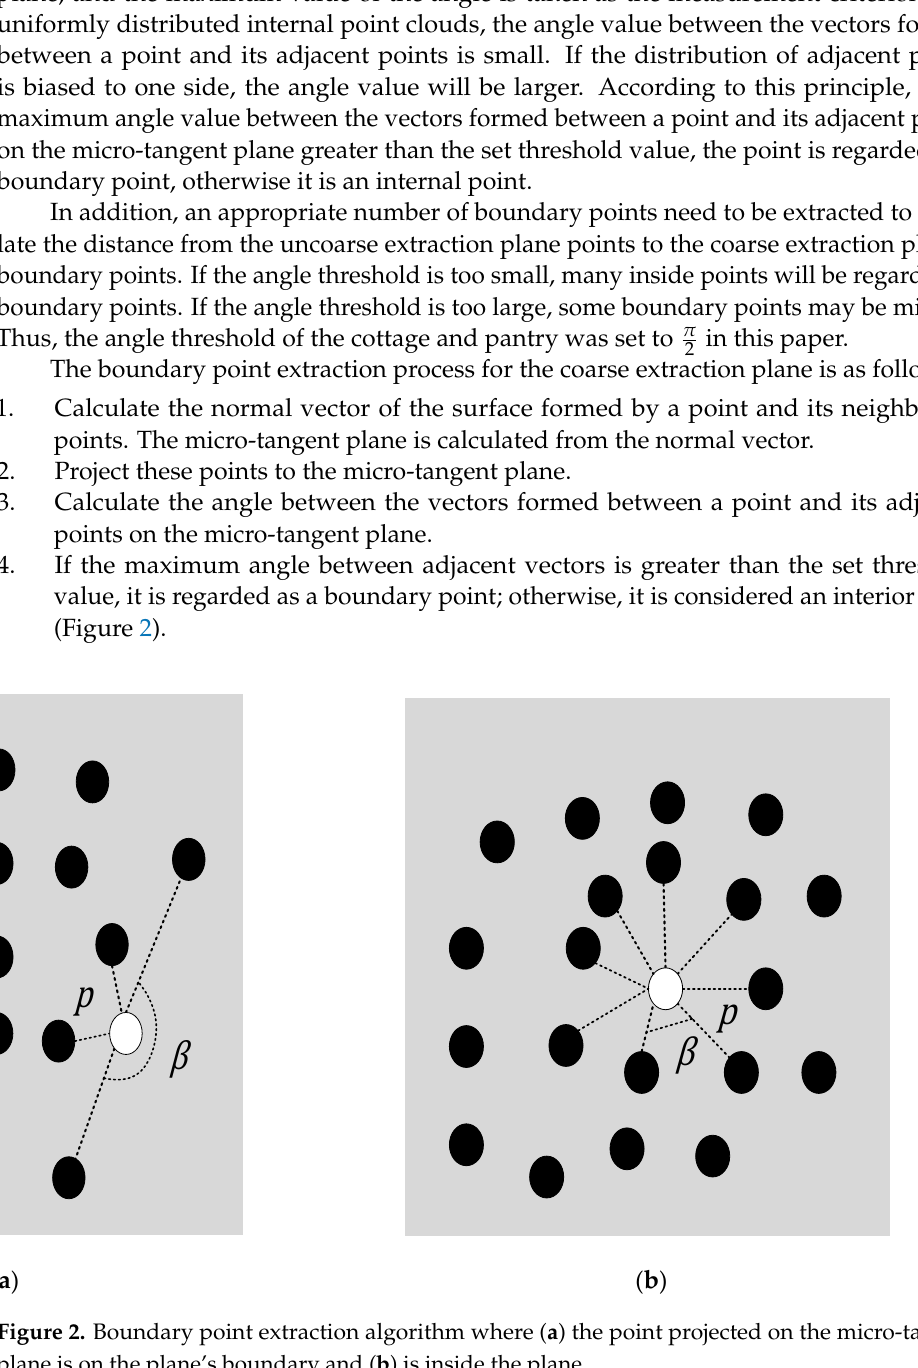
( b ) Figure 3. Boundary points extraction where ( a ) raw point cloud and ( b ) boundary points extraction results. 2.2.2. Coplanar points Extraction After the boundary points were obtained, the coplanar points at which two planes intersect were then extracted using the distance threshold from the uncoarse extraction plane points to the boundary points of the coarse extraction plane. The uncoarse extraction plane points were obtained after removing the coarse extraction plane points from the